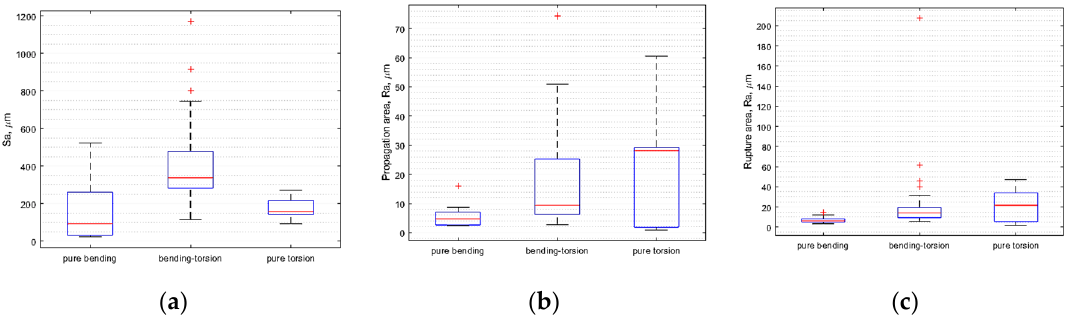
Figure 10. Box plots for results: ( a ) total fracture area; ( b ) propagation profile; ( c ) rupture profile.